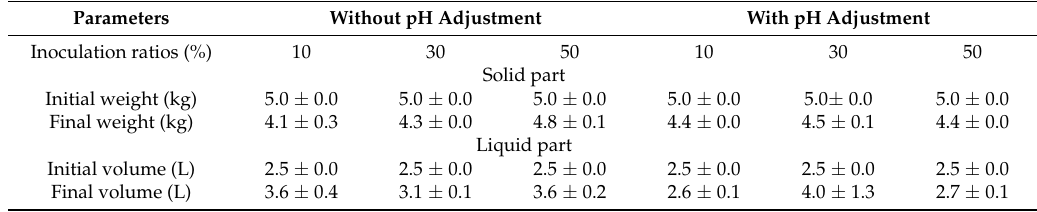
Table 1. Initial and final weight/volume of the solid (MeA mixture) and liquid part of the substrate.